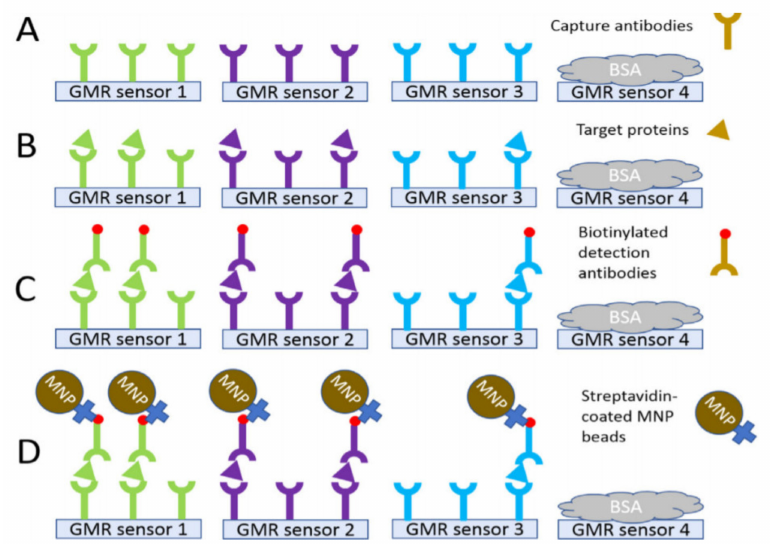
Figure 16. The Assay sequence proposed in [134] for detecting multiple magnetic nanoparticles carrying analytes. ( A ) Four groups of GMR sensors with different capture antibodies. ( B ) Samples with target proteins were introduced to the chips. ( C ) Biotinylated detection antibodies were intro- duced to the chip to selectively bind to the specific target analyte. ( D ) Streptavidin-coated magnetic nanoparticles were added to the chip surface, and GMR signals were monitored. Reprinted with permission from T. Klein, et al., 2019 Biosensors and Bioelectronics 126, 301–307 [134]. Copyright 2020